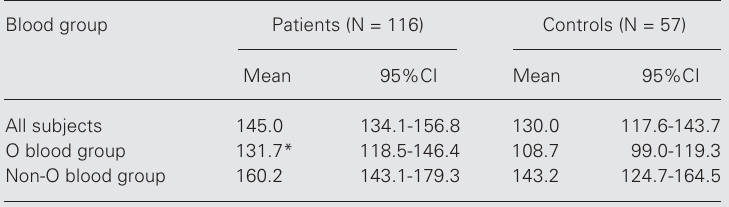
Table 2. Plasma von Willebrand factor levels in coronary artery disease patients and control subjects.